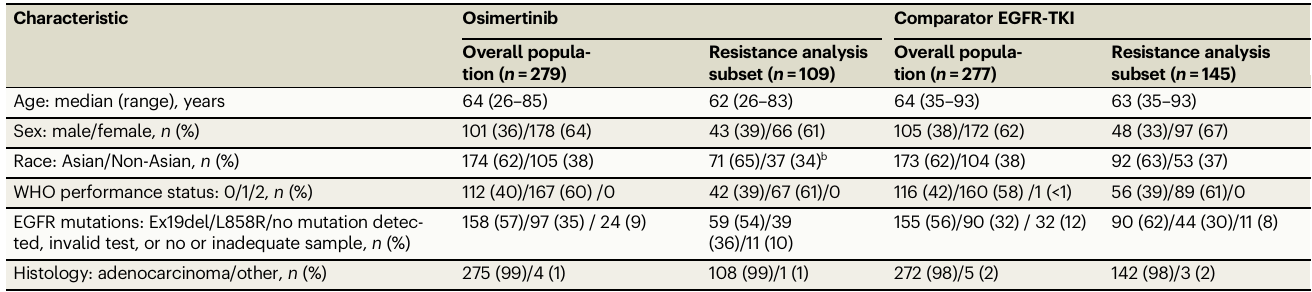
Table 1 | Patient demographics of the overall FLAURA population and the resistance analysis subset a